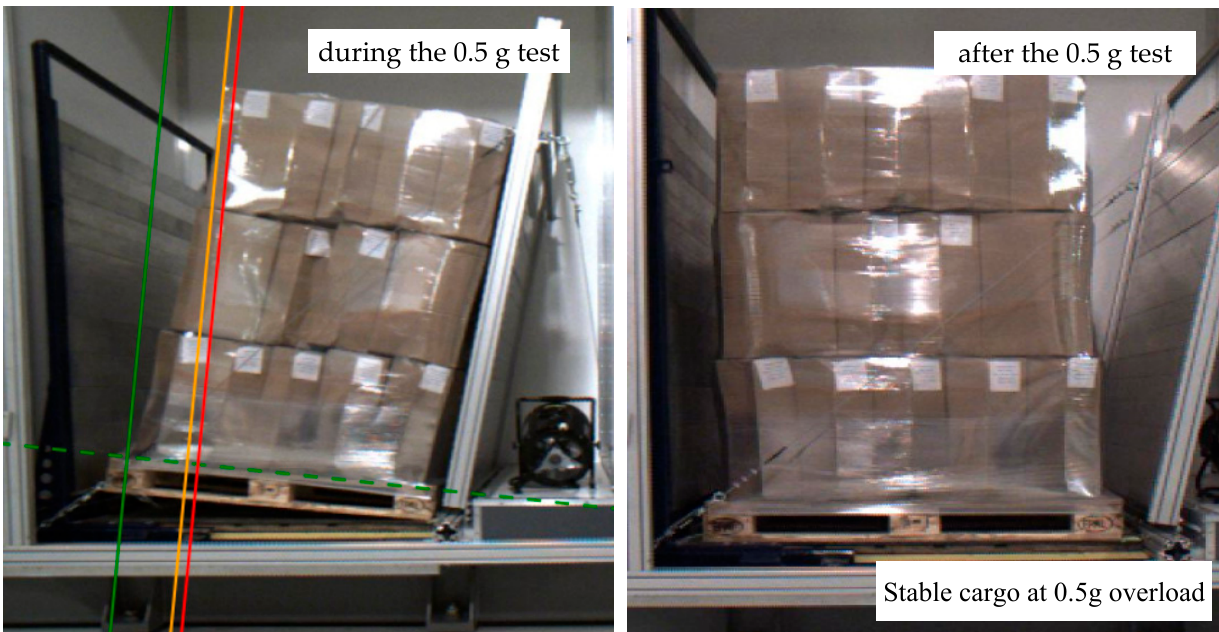
Figure 12. Cargo stability test at the set acceleration of 0.5 g.